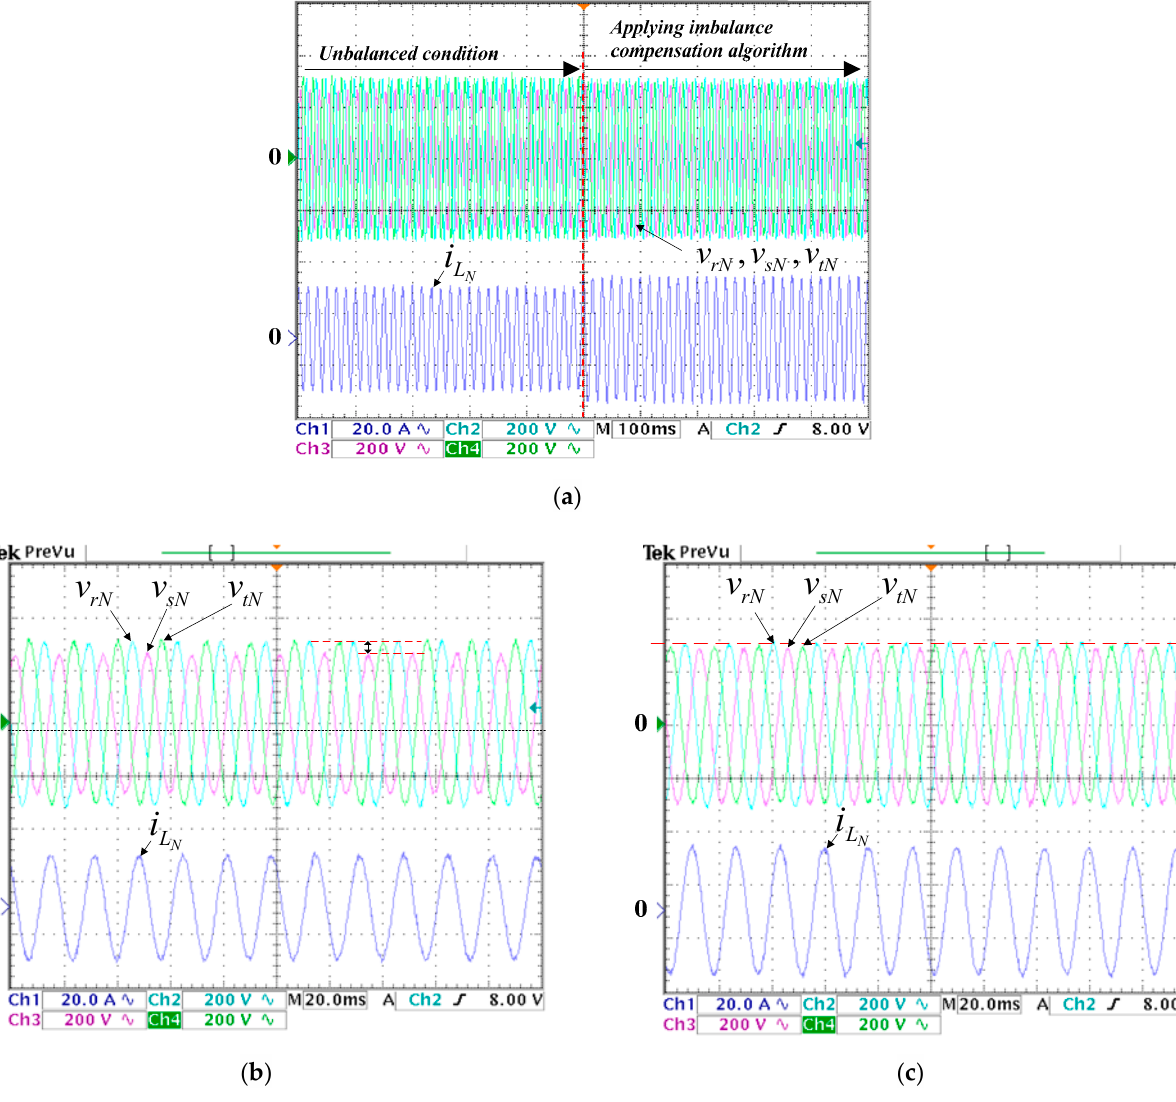
Figure 14. Experimental results before and after applying the proposed imbalance compensation control: ( a ) when applying the proposed voltage compensation control to a three-phase imbalance condition; ( b ) enlarged waveform before voltage compensation control is applied; ( c ) enlarged waveform after the proposed voltage compensation control is applied.